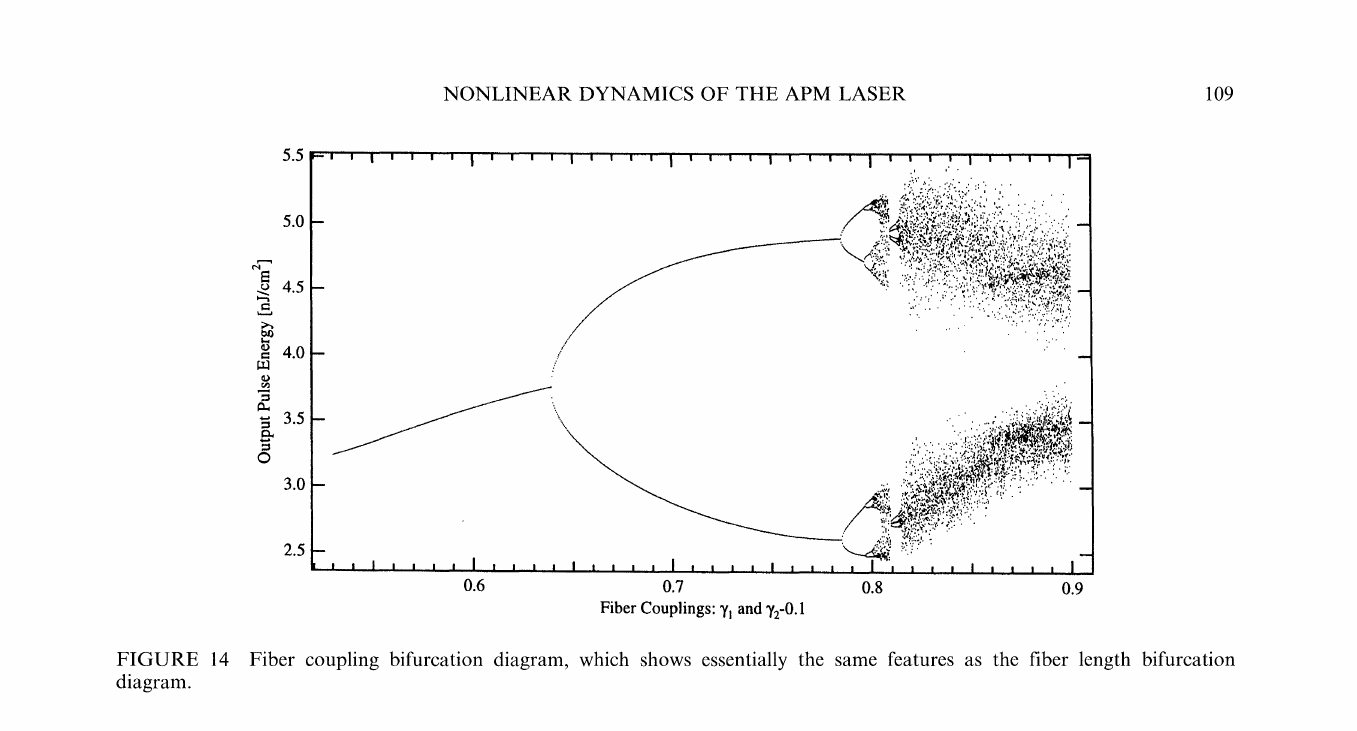
FIGURE 14 Fiber coupling bifurcation diagram, which shows essentially the same features as the fiber length bifurcation